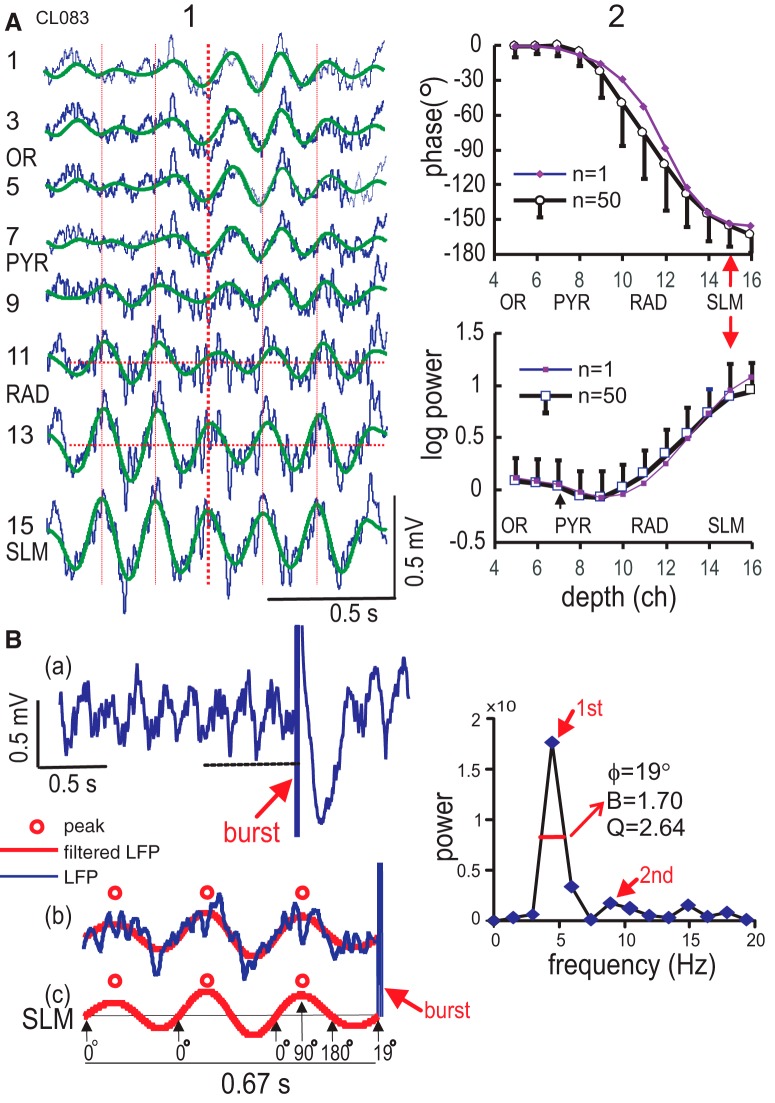

Phase profile of θ rhythm and phase reference at the distal dendritic layer. A, Laminar profile of θ rhythm recorded in selected odd channels of a 16-channel array with raw LFPs (thin trace) superimposed on 0–8 Hz digitally filtered signal (thick trace). θ Recorded in different layers: OR, PYR, RAD, and SLM. θ Phase shift was large in RAD, as could be seen from θ peak alignment with the vertical line. Column 2, Phase (top) and logarithmic power (bottom) profiles of the spontaneous θ rhythm (average of 10 segments of 1.34 s) in a single rat (CL083; n = 1), or a group of rats (n = 50), with error bars indicating one SD. The group data aligned SLM as ch15 in all rats; SLM θ showed near-maximal power and minimal phase SD. B, Estimate of θ phase at onset of burst stimulation. Column 1. Trace (a), LFP recorded at SLM shows the onset of the stimulus burst (arrow; five pulses at 200 Hz) at the rising phase of the θ rhythm. Trace (b) shows an expanded trace (horizontal line in a) of the LFP (thin trace), and digitally filtered (0–8 Hz) signal (thick trace) with peaks indicated by open circles. Trace (c) shows the filtered LFP at SLM, labeled by phase of a sine wave (0° onset, 90° peak and 270° trough). Column 2, Power spectrum, of 0.67-s LFP immediately before the burst, shows peaks at the θ 1st (4.47Hz) and 2nd harmonic (8.95 Hz), the half-peak bandwidth (B), resonance (Q), and phase estimate (ϕ = 19°) of burst onset with reference to SLM θ.